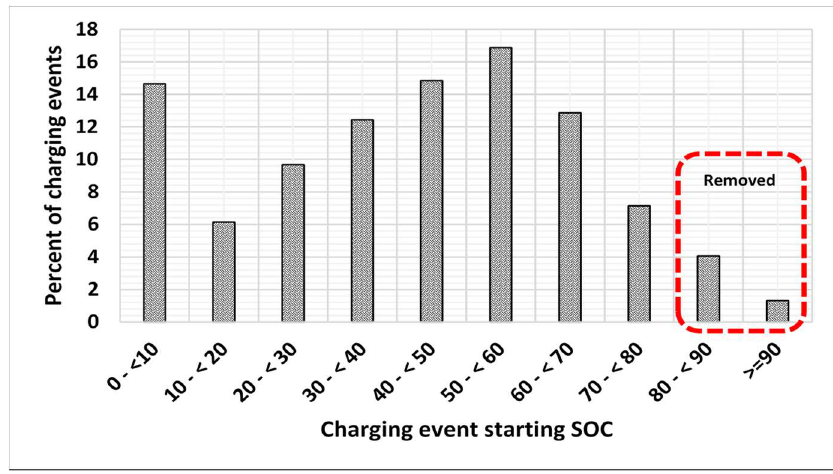
Figure 8. Average battery state of charge at the start of charging events at an